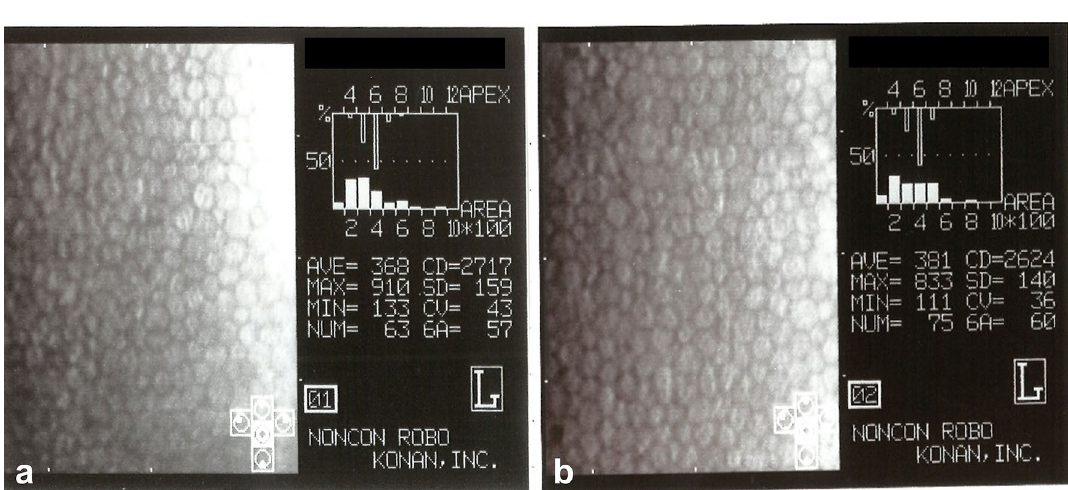
Figure 2. Representative specular microscopy findings before silicone oil (SO) implant ( a ) and before SO removal ( b ). This case was a pseudophakic 47-year-old man who underwent SO tamponade for retinal detachment recurrence. The period of SO tamponade was 258 days, and the period of SO in the anterior chamber was 189 days. During SO removal surgery, SO was found in the anterior chamber covering 14% of the corneal area. The decrease in endothelial cell density was